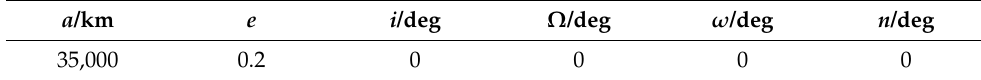
Table 4. Elements of the nominal orbit of HEO case.